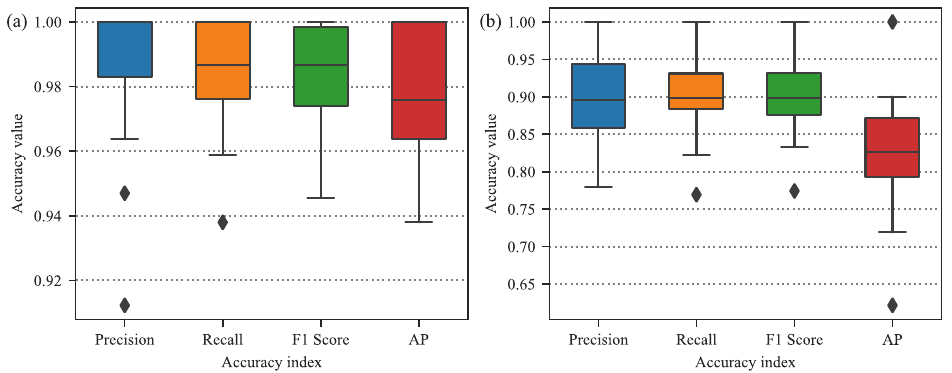
Figure 12. Box plot of the accuracy of window extraction for the IQmulus & TerraMobilita Contest dataset: ( a ) the accuracy with a min IoU of 0.5; and ( b ) the accuracy with a min IoU of 0.85. The different colored boxes represent different precision indicators. The upper and lower quartiles of the data are shown by the box’s upper and lower boundaries, respectively, and the median is shown by the inner horizontal line. The whiskers extending from the ends of the boxes are used to represent variables other than the upper and lower quartiles, and outliers are represented by black dots.